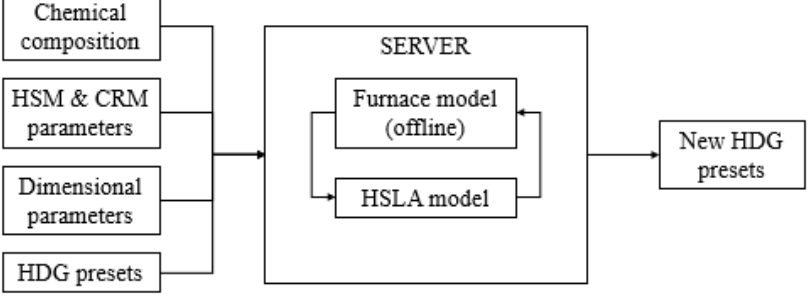
Figure 8. Integration for the HSLA model in the process